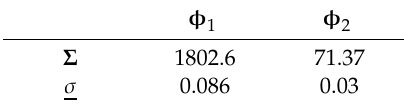
Table 5. Condition number and minimum singular value with four